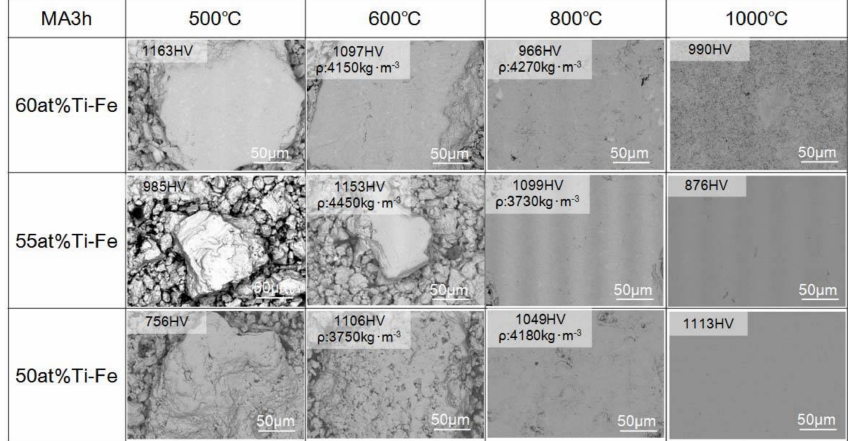
Figure 5. SEM images and micro-Vickers hardness test results and/or density measurement results of surfaces of SPS treated samples after